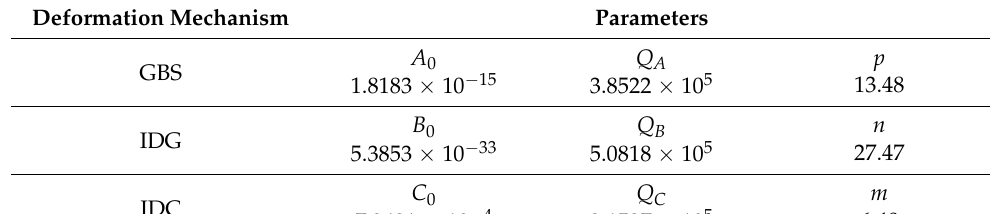
Table 4. Parameter values of creep model of CGI under different mechanisms. Deformation Mechanism